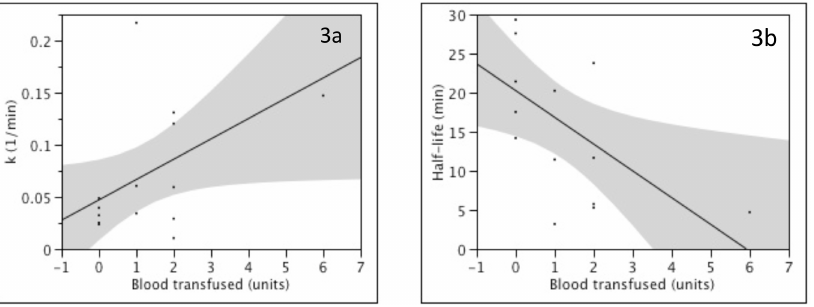
Fig 3. Transfusion of blood during reperfusion impacted HCV kinetics. Increasingvolumes of blood transfused duringthe reperfusion periodincreasedk ( A : r = 0.53, p = 0.05) and shortenedhalf-life ( B : r = 0.59, p = 0.03) (n =